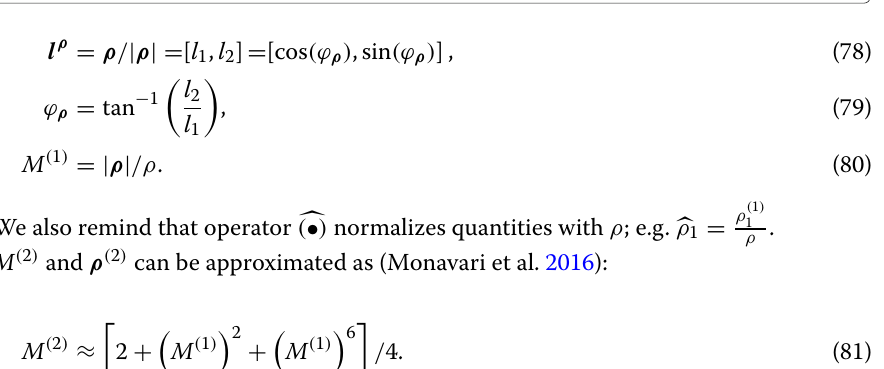
Fig. 14 Cross slip annihilation functions of ρ , ρ ( 2 ) 11 and ρ ( 2 ) 22 in CDD ( 2 ) for a DODF symmetric around edge ). For this symmetry angle M ( 1 ) = ρ 2 /ρ and M ( 2 ) = ρ 22 orientation ( ϕ ρ = π 2